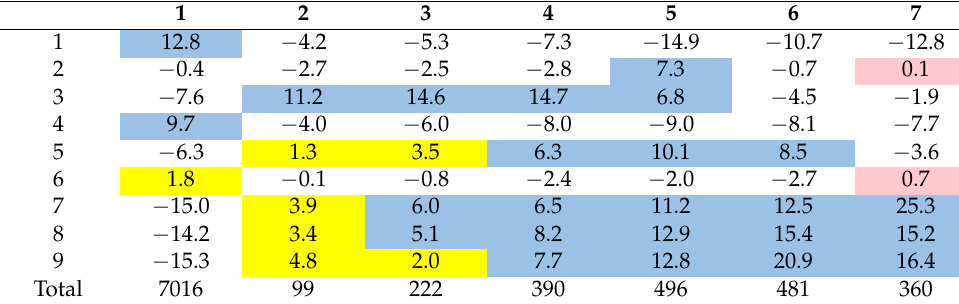
Table A14. Theoretical frequencies IMA 2006 (C1/Class_121142).